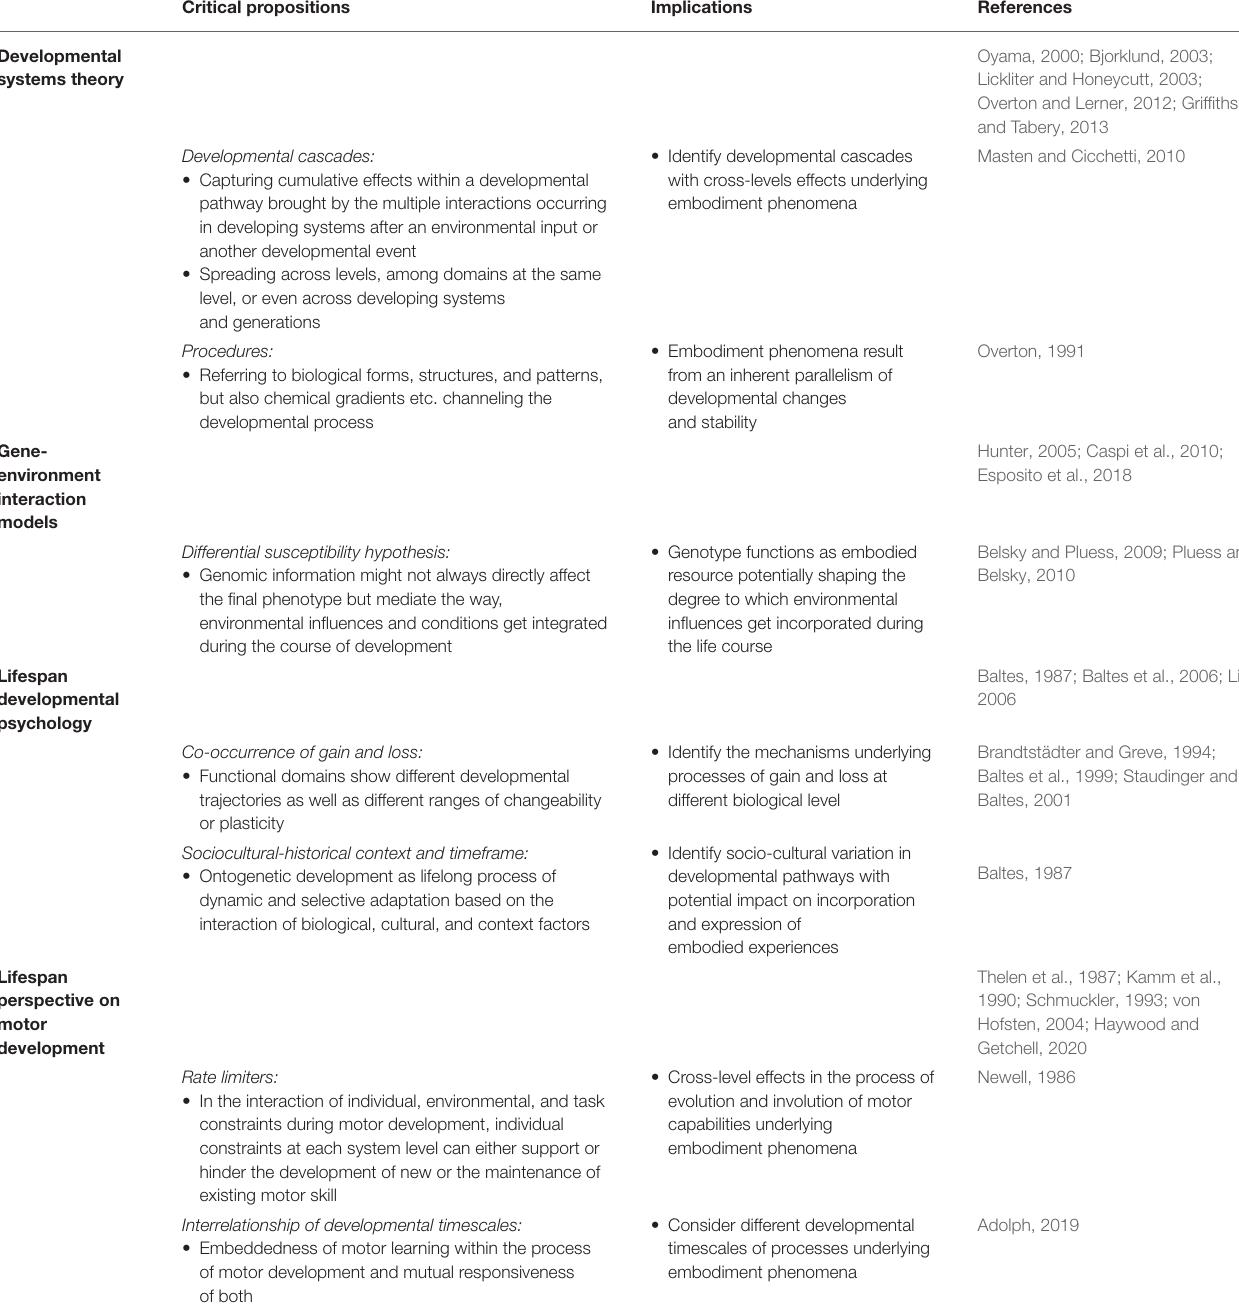
TABLE 2 | Lifespan developmental theories and their critical propositions and implications for developmental embodiment